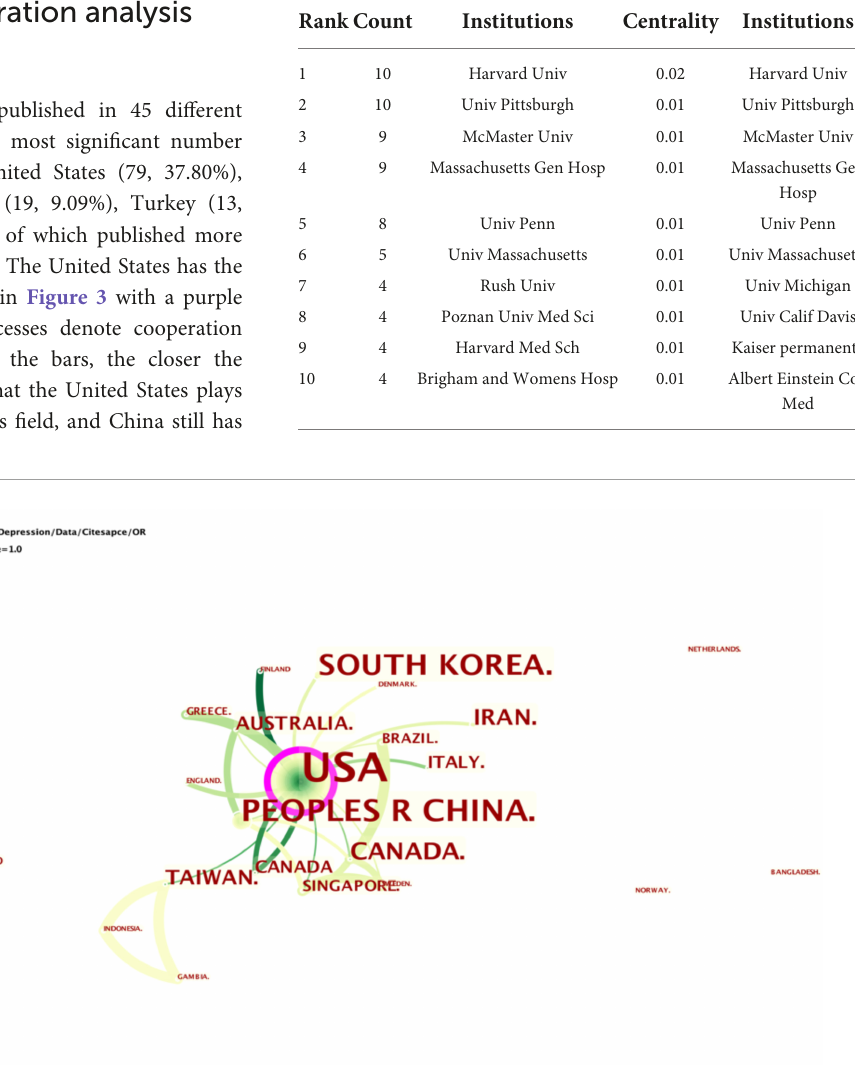
TABLE 2 Top 10 institutions related to PMD.